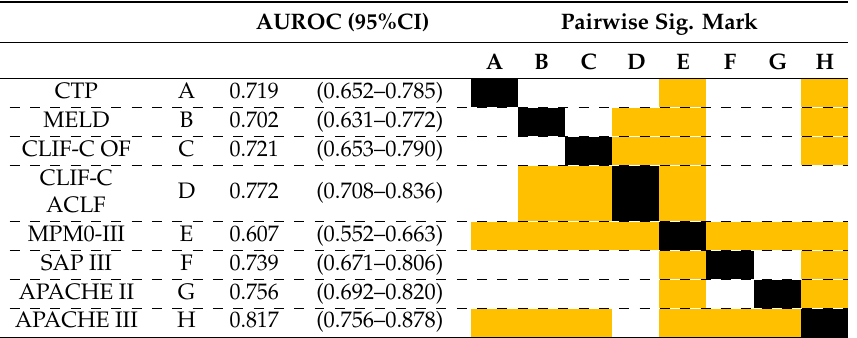
AUROC: area under receiver operating characteristic curve; The yellow color regions reflect significant difference in pairwise comparison at significance level α = 0.05 and is more important than the black ones.